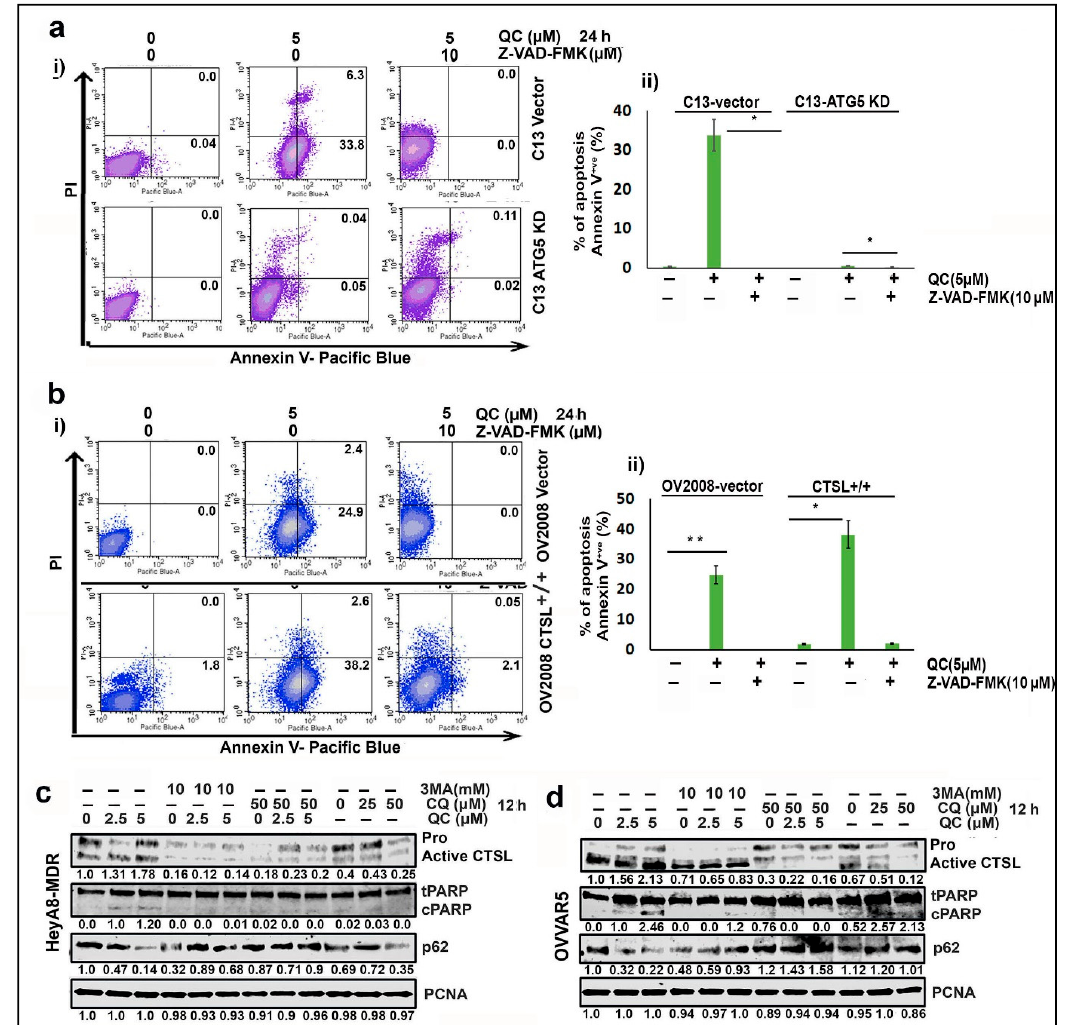
Figure 3 . QC promotes CTSL upregulation in an autophagy-dependent manner. ( a ( i )) C13 ATG5 WT and KD cells were treated with 5 µM QC in the absence and presence of caspase inhibitor Z-VAD-FMK (10 µM) for 24 h and stained with Annexin V-Pacific Blue and Propidium Iodide (PI) followed by FACS analysis to determine the early and late apoptotic events, and ( ii ) the bar graph depicts percentage of Annexin-V-positive/apoptotic cells. ( b ( i )) Similar analysis was per- formed in the OV2008 cells (vector and CTSL +/+ ) and ( ii ) the pictograph shows percentage of Annexin-V-positive cells. ( c ) HeyA8-MDR and ( d ) OVCAR5 cells were treated with QC (0, 2.5, 5 µM) in the absence and presence of autophagic inhib- itor 3MA (10 µM) and/or CQ (0, 25, 50 µM) for 24 h and immunoblot analysis was performed against CTSL, p62 and cleaved PARP proteins. Significance was expressed as * p < 0.05, ** p < 0.01, *** p < 0.001. Abbreviations: QC: Quinacrine; 3MA: 3 Methyladenine; CQ: Chloroquin; CTSL: Cathepsin L; PARP: Poly (ADP-ribose) Polymerase; p62: Ubiquitin bind- ing Protein 62 and PCNA: Proliferating Cell Nuclear Antigen. To further confirm the induction of autophagic flux, we monitored the fluorescence of GFP-RFP-LC3B/or p62 construct in both the C13 and HeyA8 MDR cells upon treatment with QC for 24 h. The conversion of early autophagosome or p62 inclusion body into au- tolysosome was monitored by formation of green (GFP+ and RFP − ) to yellow puncta (GFP+ and RFP+) and increased red puncta (GFP − and RFP+) in the cells (Figure 4a). Con- focal images of the transiently transfected GFP-RFP-LC3B/or p62 construct in C13 (Figure 4b,c) and HeyA8-MDR (Figure 4d,e) cells showed induction of autophagic flux through the formation of both yellow/orange (GFP/RFP) and increased red-RFP puncta in 5 µM